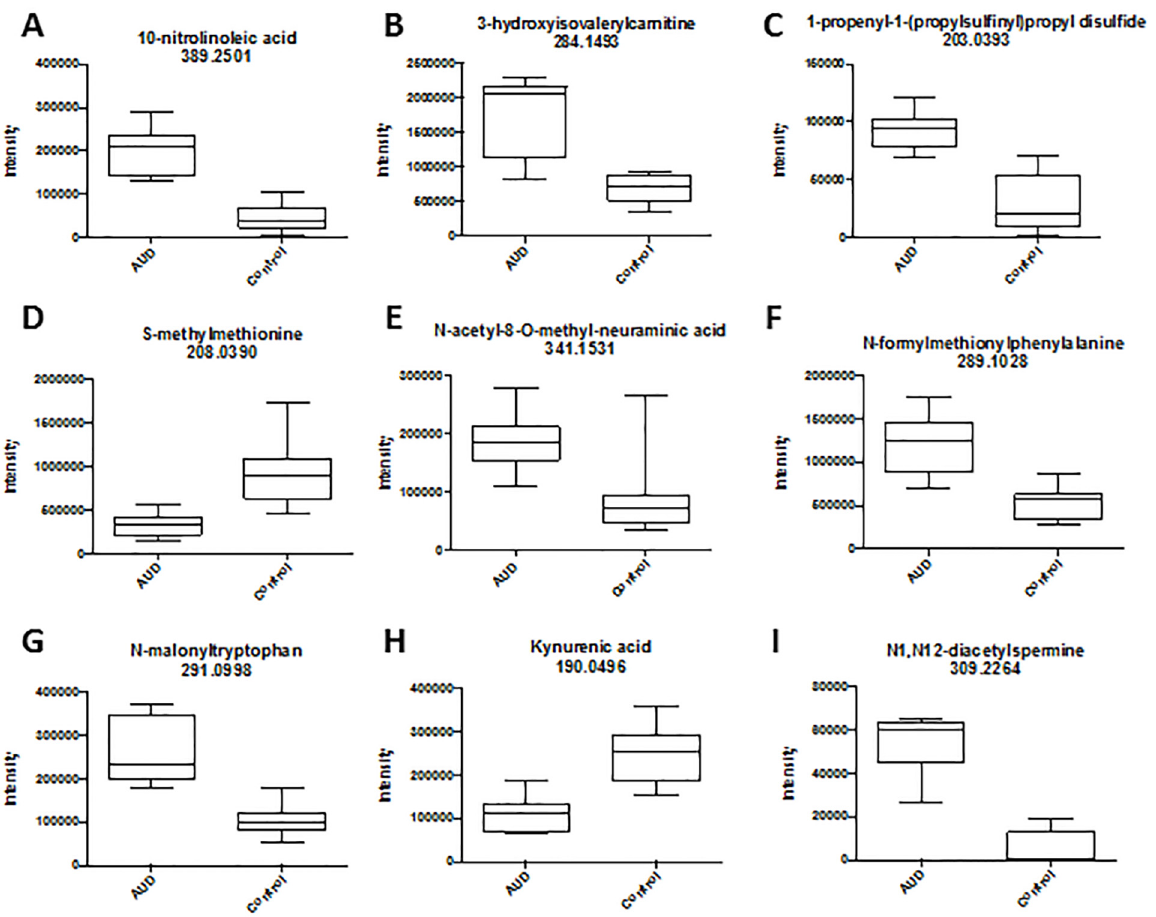
Fig 5. Box-and-whisker plots of selected significant features. The plots compare the mean intensity of each feature between the two